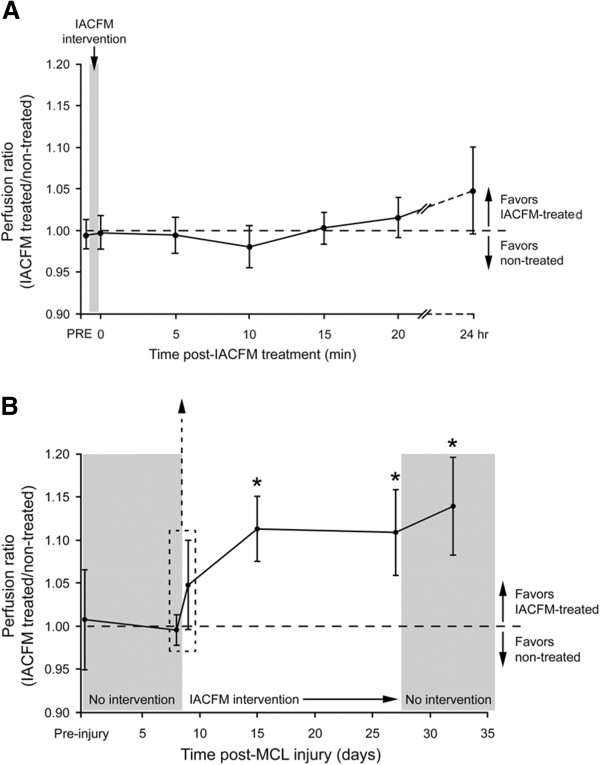
Effect of IACFM on regional tissue perfusion following knee MCL injury. A: IACFM had no immediate effect on tissue perfusion ratios, with ratios immediately prior (PRE) and after (0) the first IACFM treatment, at 5, 10, 15 and 20 minutes post-treatment, and at 24 hours post-treatment not differing significantly from 1 (i.e. perfusion in IACFM-treated = perfusion in non-treated). B: IACFM significantly increased tissue perfusion over time. In addition to having increased perfusion when assessed at 24 hours after the 4th and last (9th) treatment (15 and 26 days post-MCL injury, respectively), IACFM treated hindlimbs had significantly greater perfusion when assessed one week following the final treatment session (32 days post-MCL injury). Data represent perfusion ratios (IACFM treated/non treated) between IACFM treated and non-treated hindlimbs, with error bars indicating the 95% confidence interval. Ratios >1 indicate greater perfusion in IACFM-treated hindlimbs. *p < 0.05, as determined by single sample t-tests with a population mean of 1.